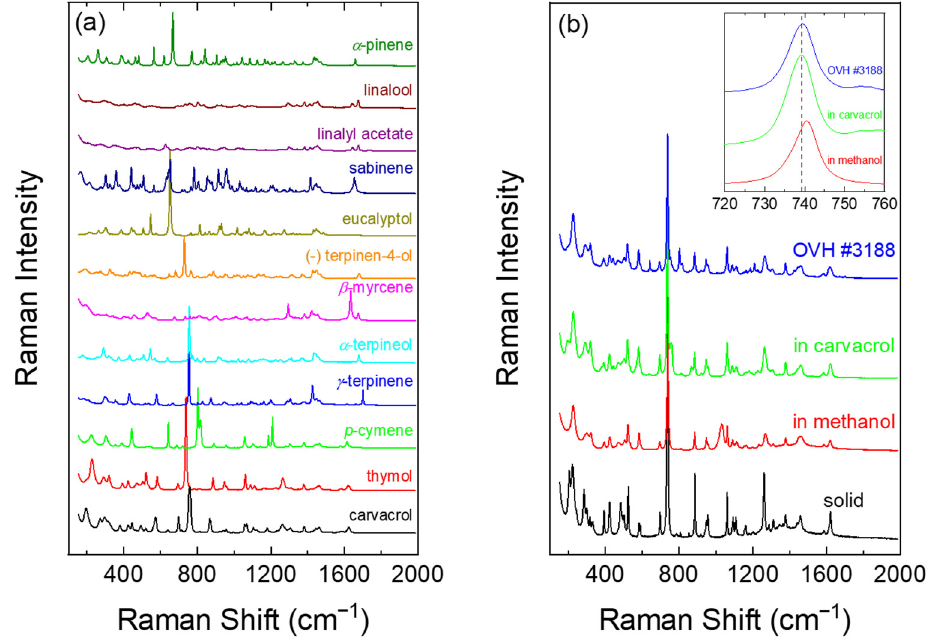
Figure 2. ( a ) Raman spectra acquired from available reference compounds, usually present in the Origanum essential oils, ( b ) comparison of the spectrum of an essential oil with high content of thymol ( Origanum vulgare subsp. hirtum : OVH, #3188) with those of solid thymol, as well as solid thymol dissolved in methanol and carvacrol; the inset illustrates the spectral region of the 740 cm − 1 thymol peak, with the vertical dashed line marking its frequency in the EO of sample #3188.